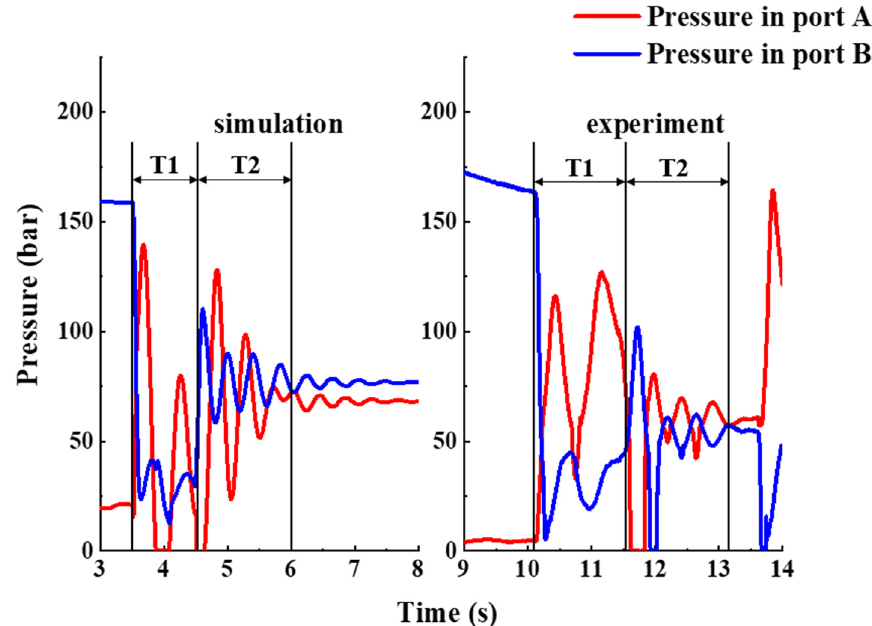
Figure 7. Comparison chart of simulation and test results.